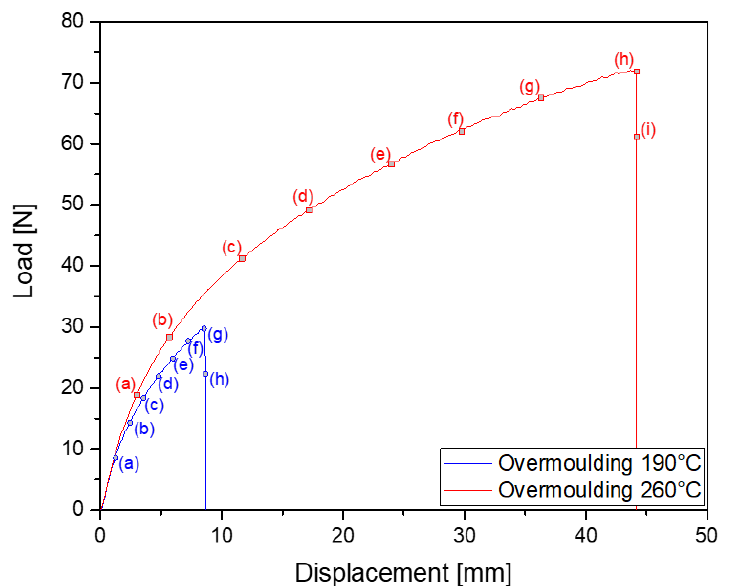
Figure 4. Tensile mechanical response up to failure of 190 ◦ C and 260 ◦ C overmoulded specimens. Letters (a) to (i) and (a) to (h) refer to the letters of images taken at different displacements and given in Figures 5 and 6, respectively.